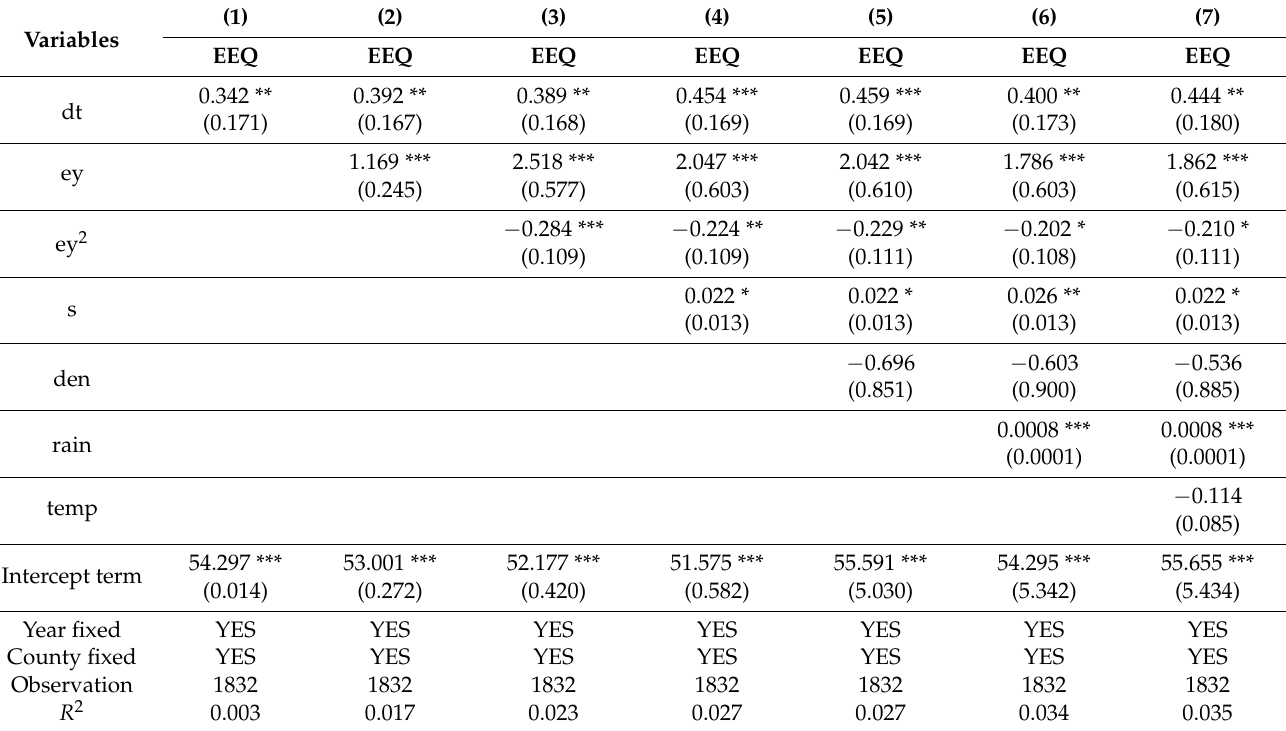
Table 3. Results analysis of MERCOCL on the effect of